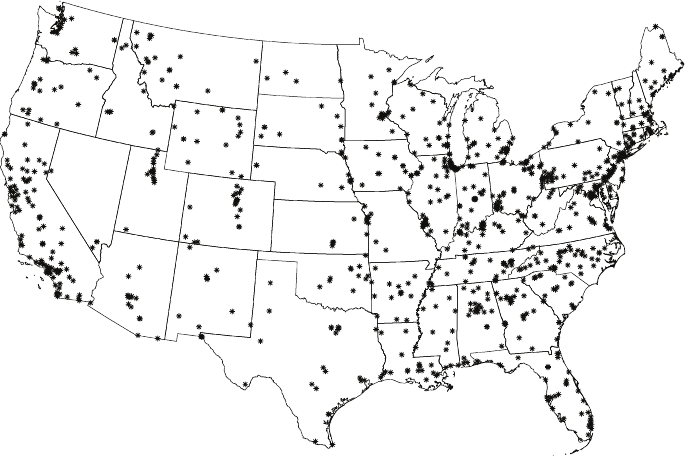
Figure 2. U.S. Environmental Protection Agency (EPA) monitoring sites. These monitoring sites have PM 2.5 (fine particulate matter) measurements across the contiguous United States in